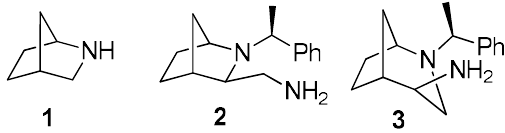
Figure 1. The 2-azanorbornane ( 1 ) and isomeric amines containing bicyclic skeletons ( 2 , 3 ) .